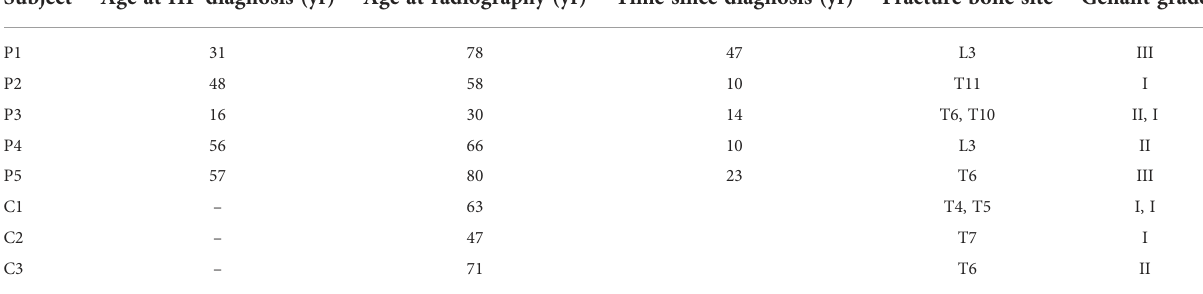
TABLE 3 Site and Genant classi fi cation of morphometric vertebral fractures in patients with postsurgical hypoparathyroidism and